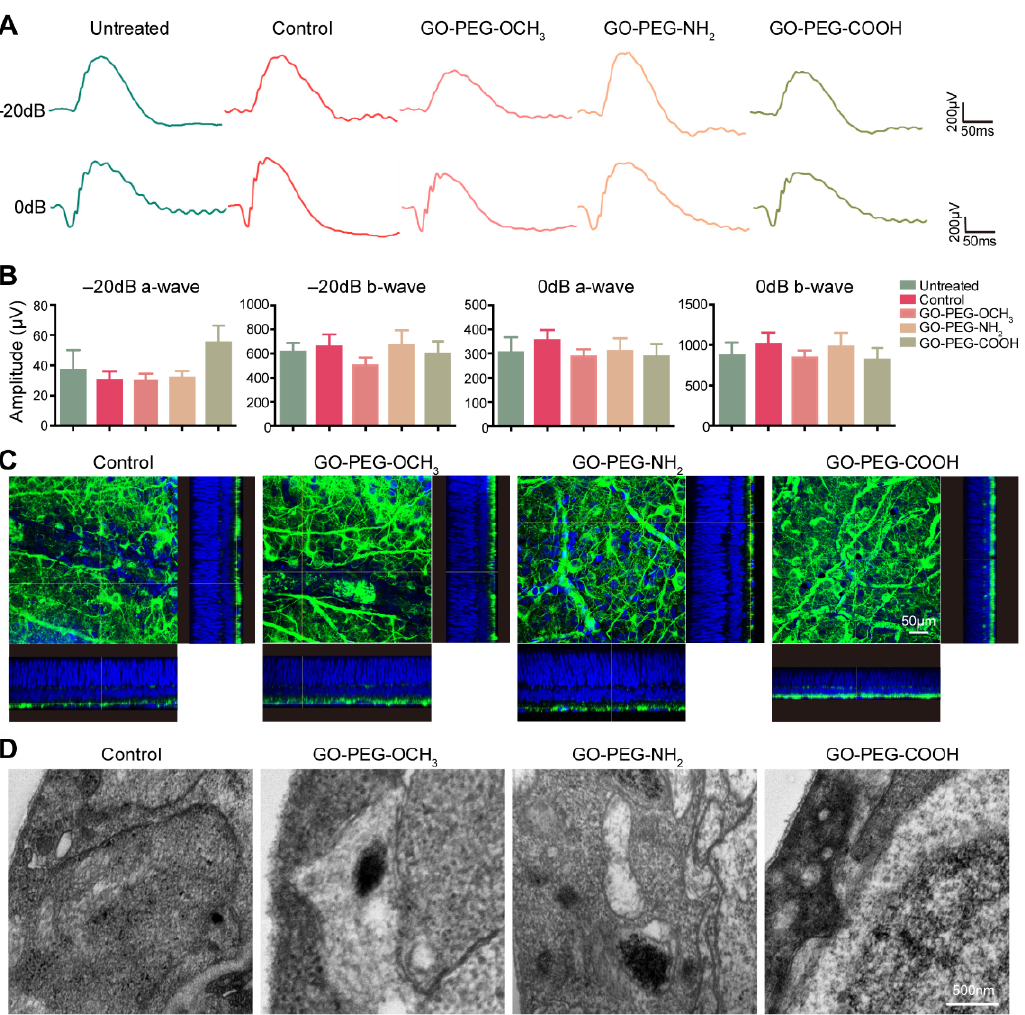
Figure 5. Intraocular irritation test of PEG-GO nanosheets. ( A ) Representative images of scotopic electroretinogram at flash intensity of − 20 dB and 0 dB 4 weeks after intravitreal injection of PEG-GO nanosheets. ( B ) Group data of the amplitude of a-wave and b-wave. Bars show mean ± S.D. ( C ) Representative immunofluorescence images of the retinal whole mount with z scanning, showing the retinal ganglion cells (green). The cell nuclei were displayed in blue. Scale bars = 50 µ m. ( D ) Representative ultrastructural images showing the retinal ganglion cells layer. Scale bars = 500 nm.